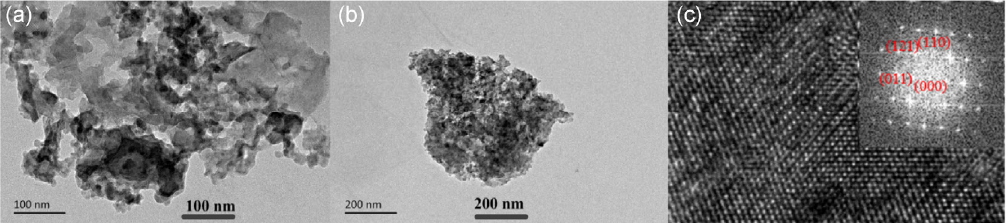
Fig. 10 (a) and (b)TEM images of the black phosphorus nanosheets obtained at 3,000 rpm showing the nanosheets with lengths in few hundreds of nanometers; (c) HRTEM image of the